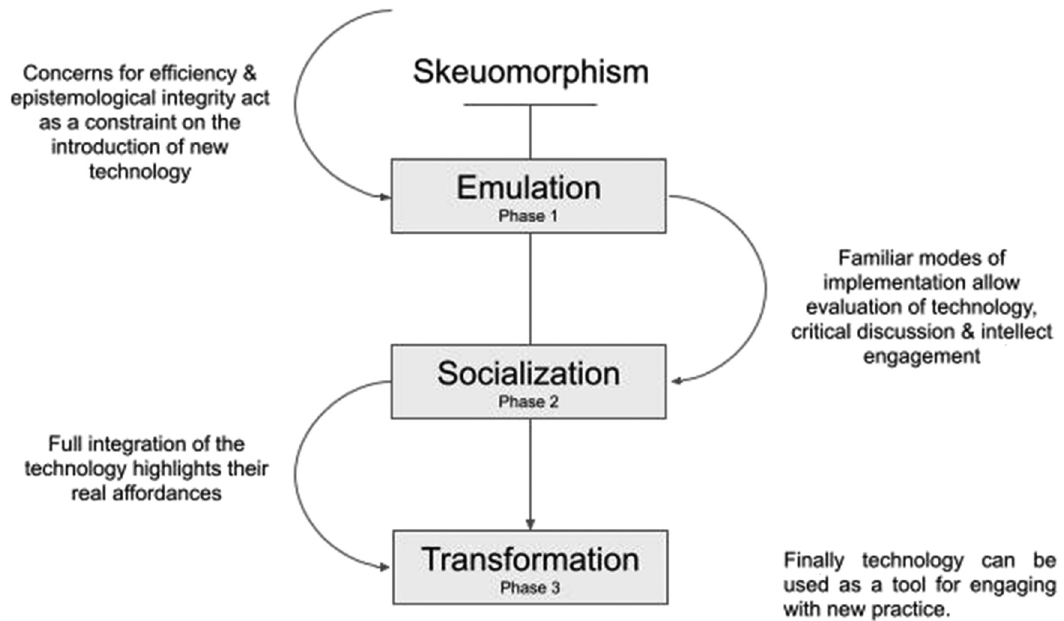
Figure 1: Diagram showing how the process of adopting accepting and integrating new or emergent technology ( such as 3D recording and visualization ) may move through successive conceptual phases of practice ( emulation, socialization, and transformation ) by an archeological team, highlighting the importance of “ skeuomorphic practice ” as described by the authors. The three steps are connected by episodes, which occurred during the process that might equally occur at a disciplinary